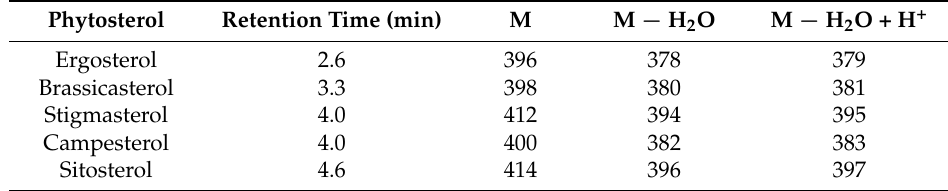
Table 11. Retention times (RT) and specific ions of the